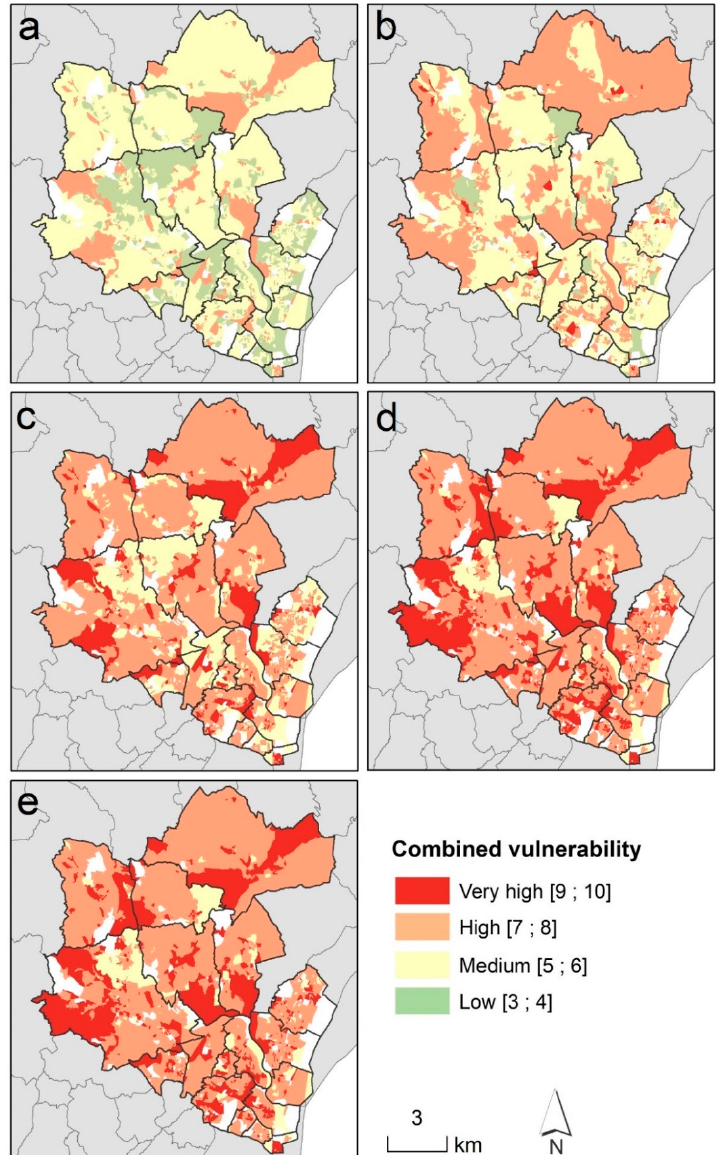
Figure 5. Combined vulnerability for residents living in buildings potentially affected by a landslide body, for slip surface depth of ( a ) 1 m; ( b ) 3 m; ( c ) 5 m; ( d ) 10 m; and ( e ) 20 m. White polygons are BGRI subsections without buildings.